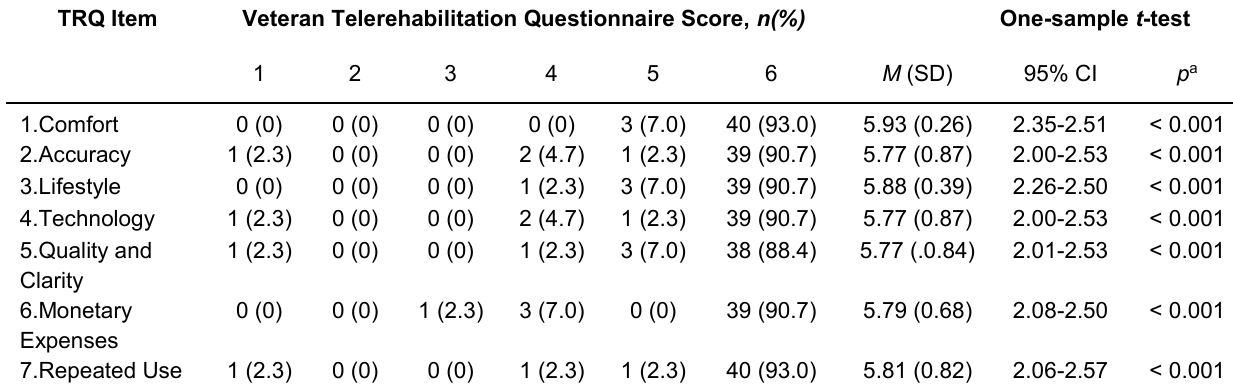
Veteran Satisfaction with Telerehabilitation Assessment